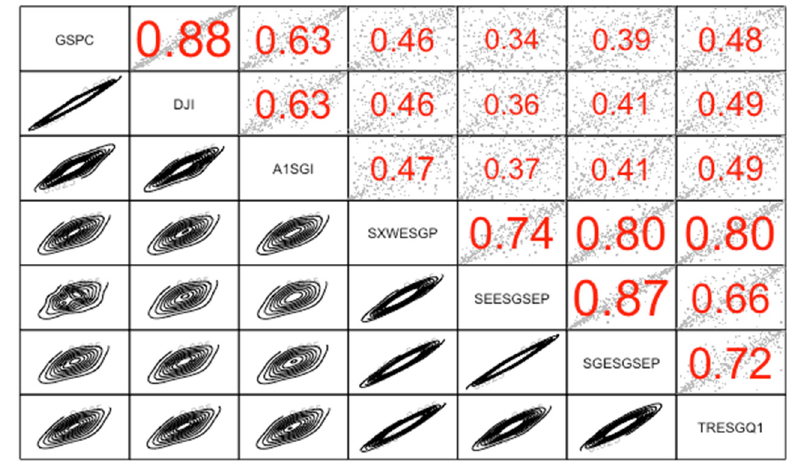
Figure 1. The rates of return 3 July 2007–30 January 2009.